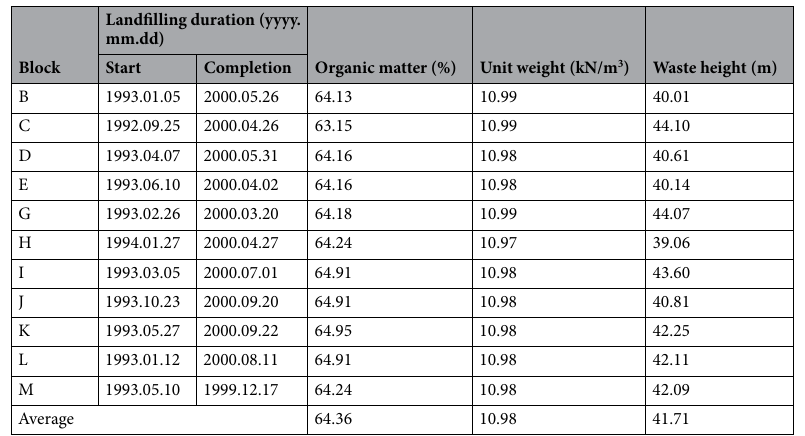
Table 1. The landfilling duration, the proportion of organic matter, unit weight, and waste height for each block in landfill #1. The detailed landfilling history for each lift of the blocks is presented in Table S2. The organic matter consists of food, paper, wood, textiles, rubber, and leather (the detailed annual composition is presented in Table